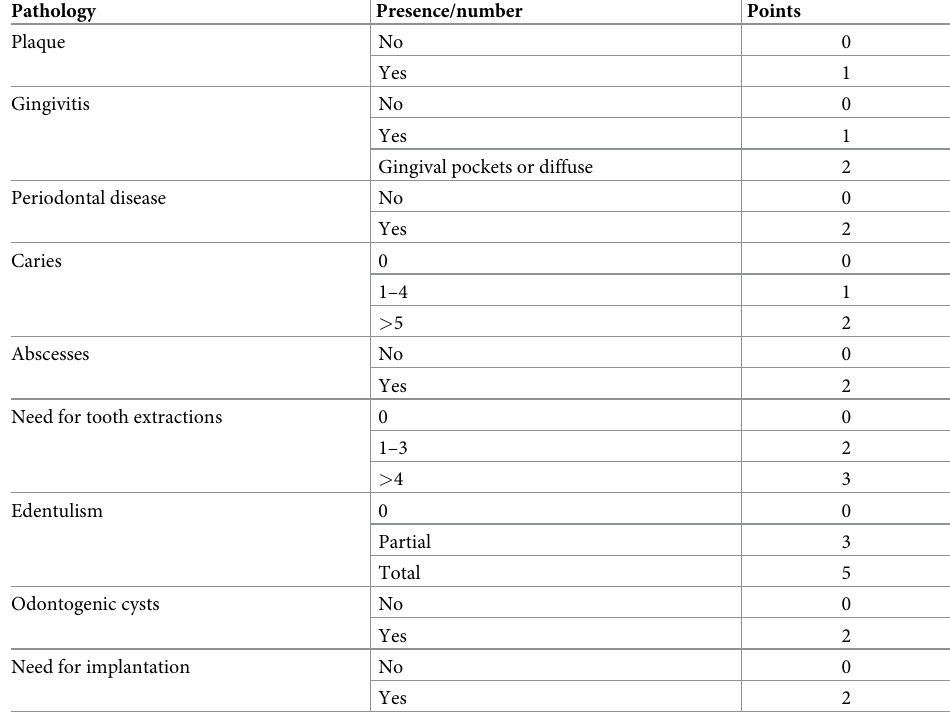
Table 1. Score to categorize the severity of oral pathology: Absent if the sum of points equals 0, mild if it is between 1 and 3, moderate 4–6, severe � 7.